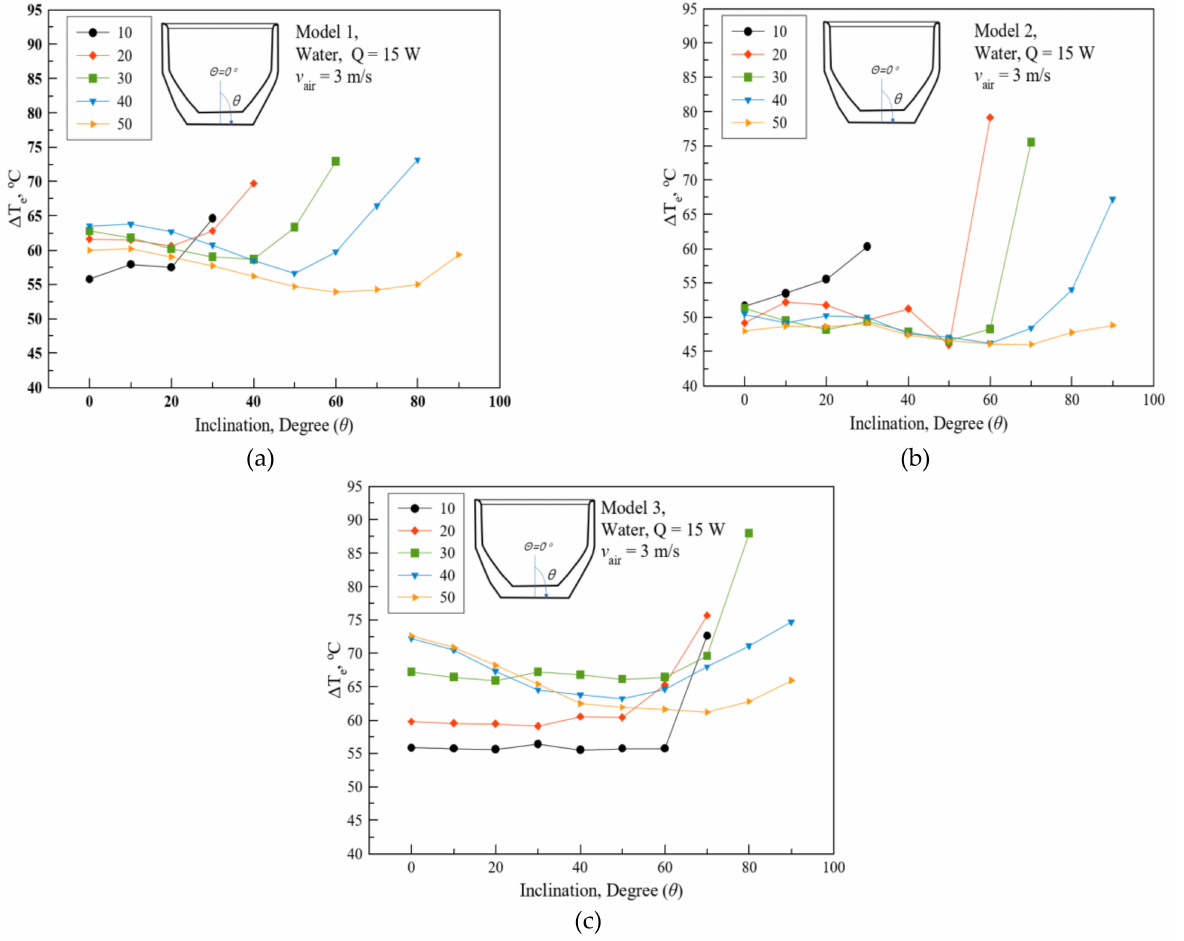
Figure 10. Effect of the inclination of the HSVC. ( a ) Model 1. ( b ) Model 2. ( c ) Model 3. Transient Temperature